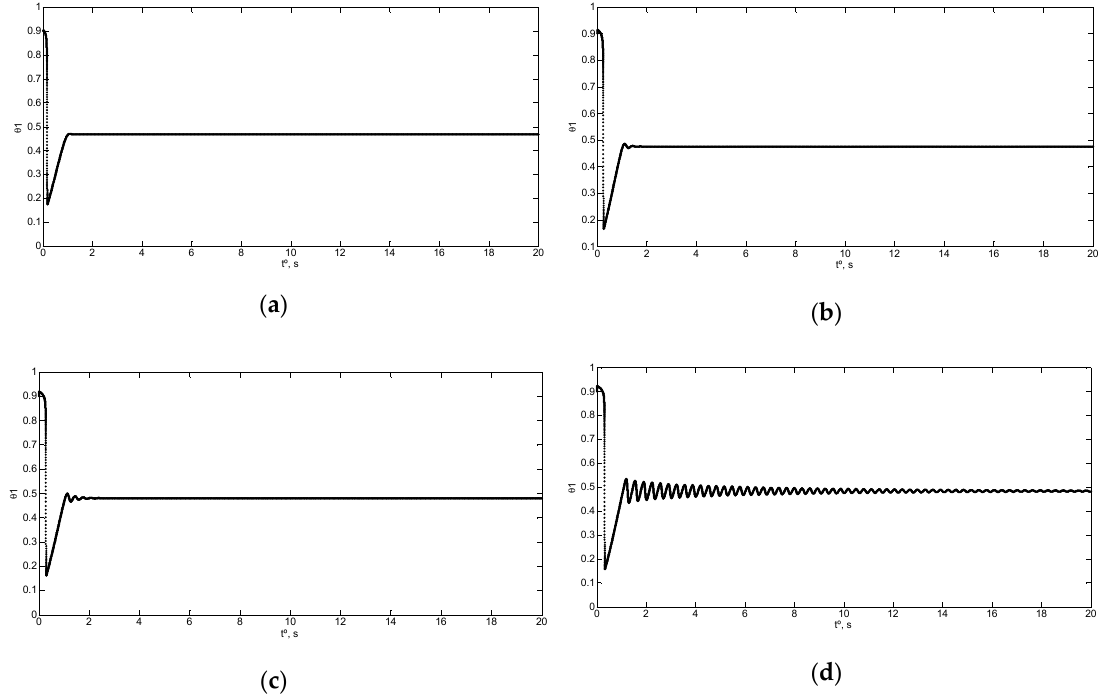
Figure 9. Superficial fractional coverage of carbon monoxide evolution with time step = 2·10 − 4 s and at P 1 : ( a ) 94.6572 Pa, ( b ) 97.3236 Pa, ( c ) 98.6568 Pa and ( d ) 99.992 Pa.